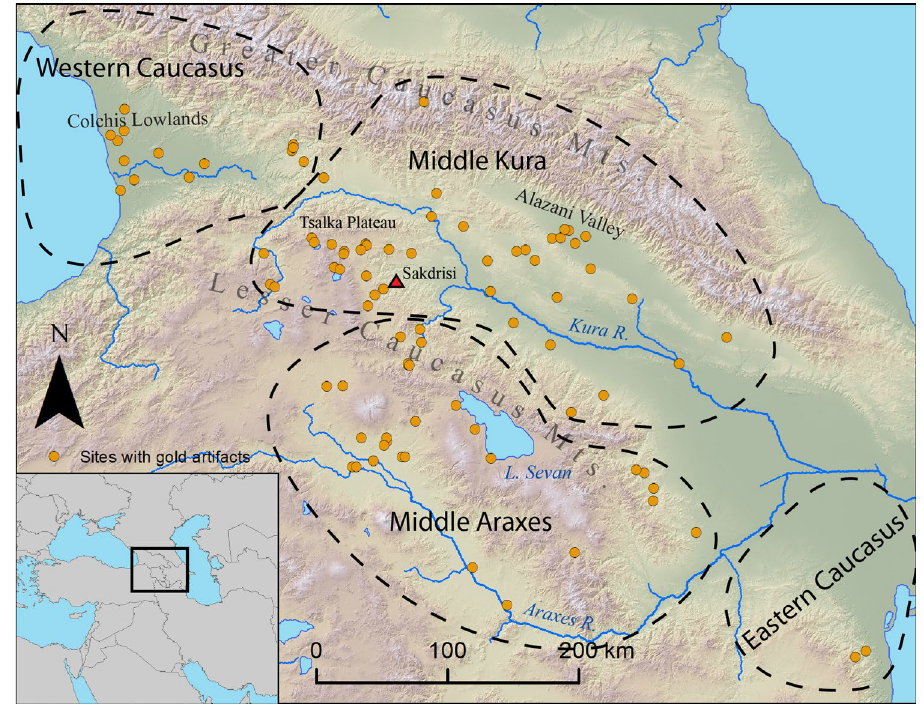
Figure 1. Map of the South Caucasus showing sites with gold artifacts and geographic zones used in the subsequent analysis. The Sakdrisi Early Bronze Age gold mine is indicated by a red